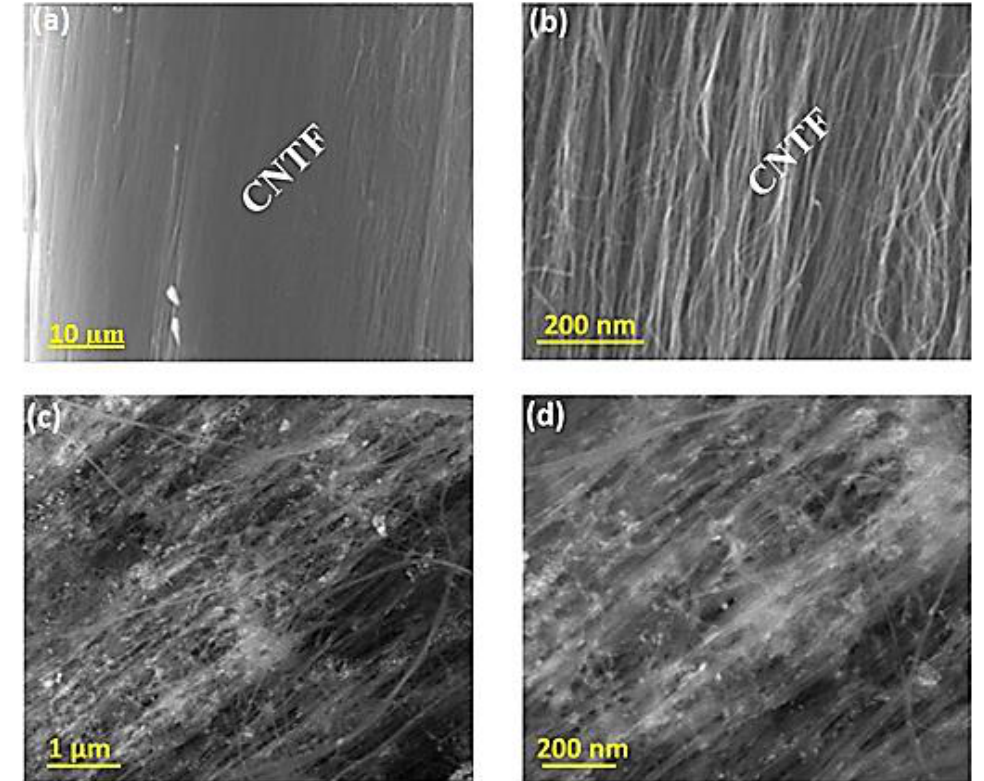
Figure 1. SEM images of ( a , b ) bare CNTF and ( c , d ) Co 4 POM@CNTF at different magnifications.